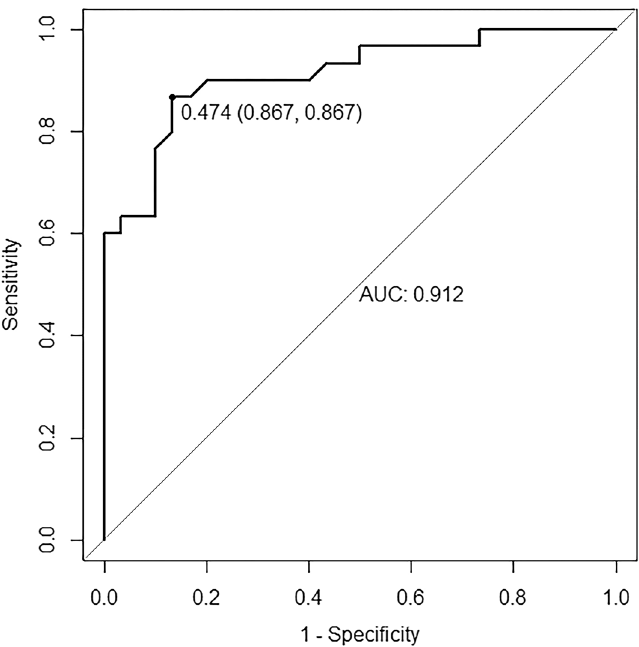
Figure 3. The ROC and AUC of the proposed